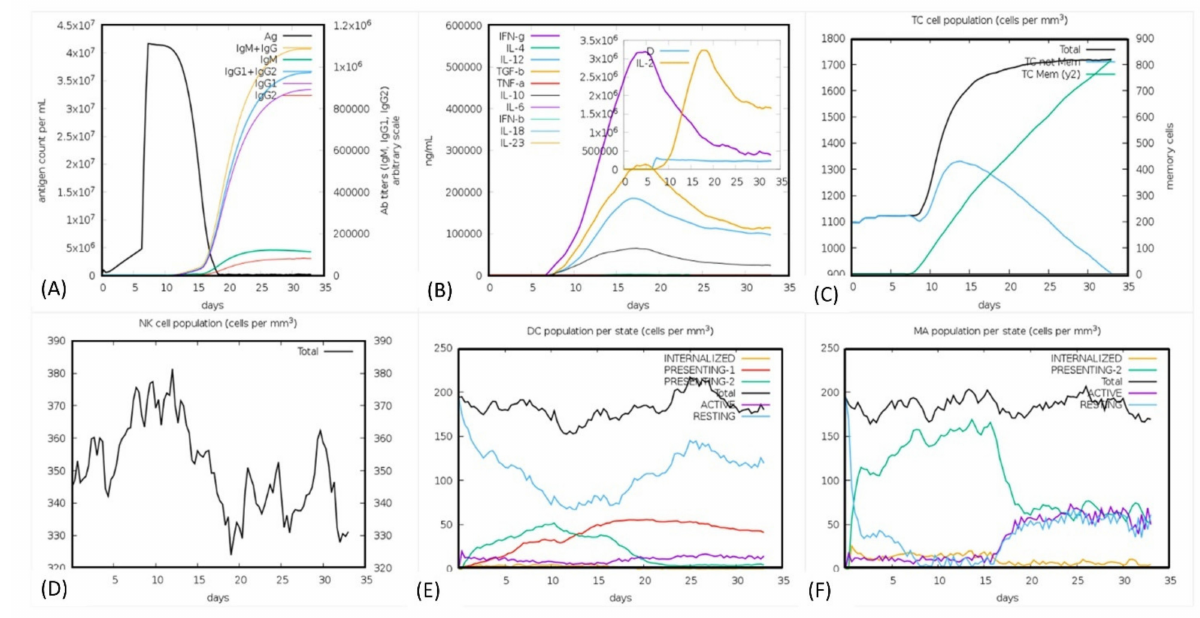
Figure 9. ( A ) Antibodies titer, ( B ) cytokines and interleukins concentrations, ( C ) T cell population, ( D ) NK cell population ( E ) dendritic cell population, and ( F ) macrophage population production in response to the